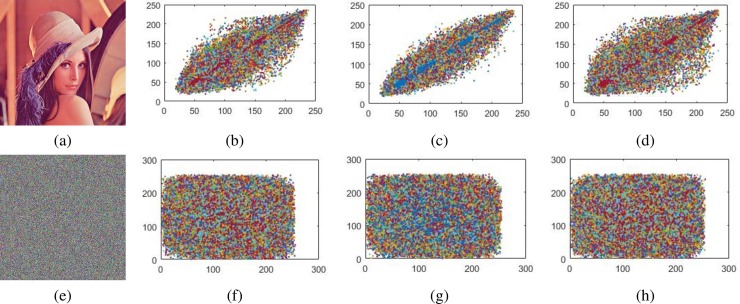
Correlation coefficient between pixel pairs for original and encrypted Lena image.(a) Plain Lena image. (b) Horizontal correlation. (c) Vertical correlation. (d) Diagonal correlation. (e) Encrypted Lena image. (f) Encrypted Horizontal correlation. (g) Encrypted Vertical correlation. (h) Encrypted Diagonal correlation.